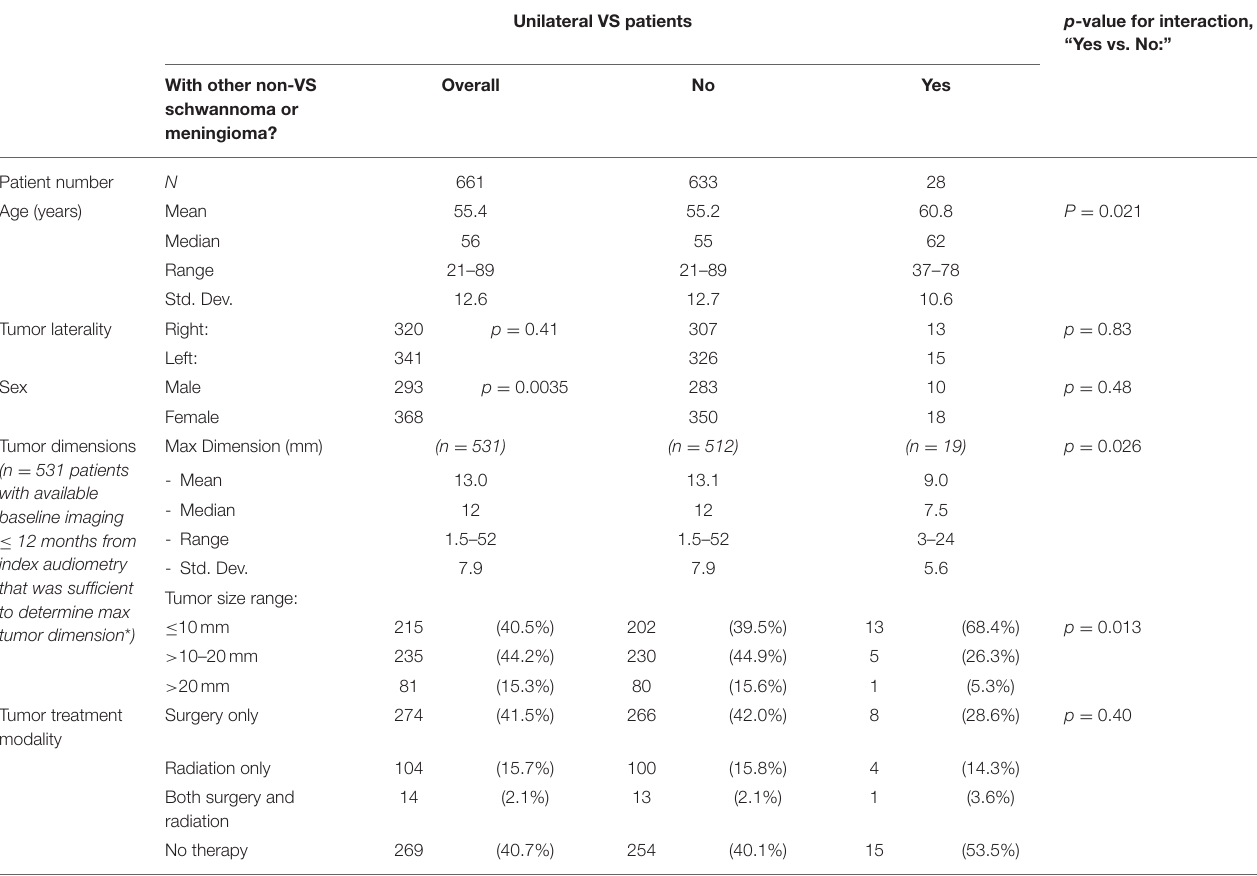
TABLE 1 | Demographics in patients with sporadic unilateral VS.